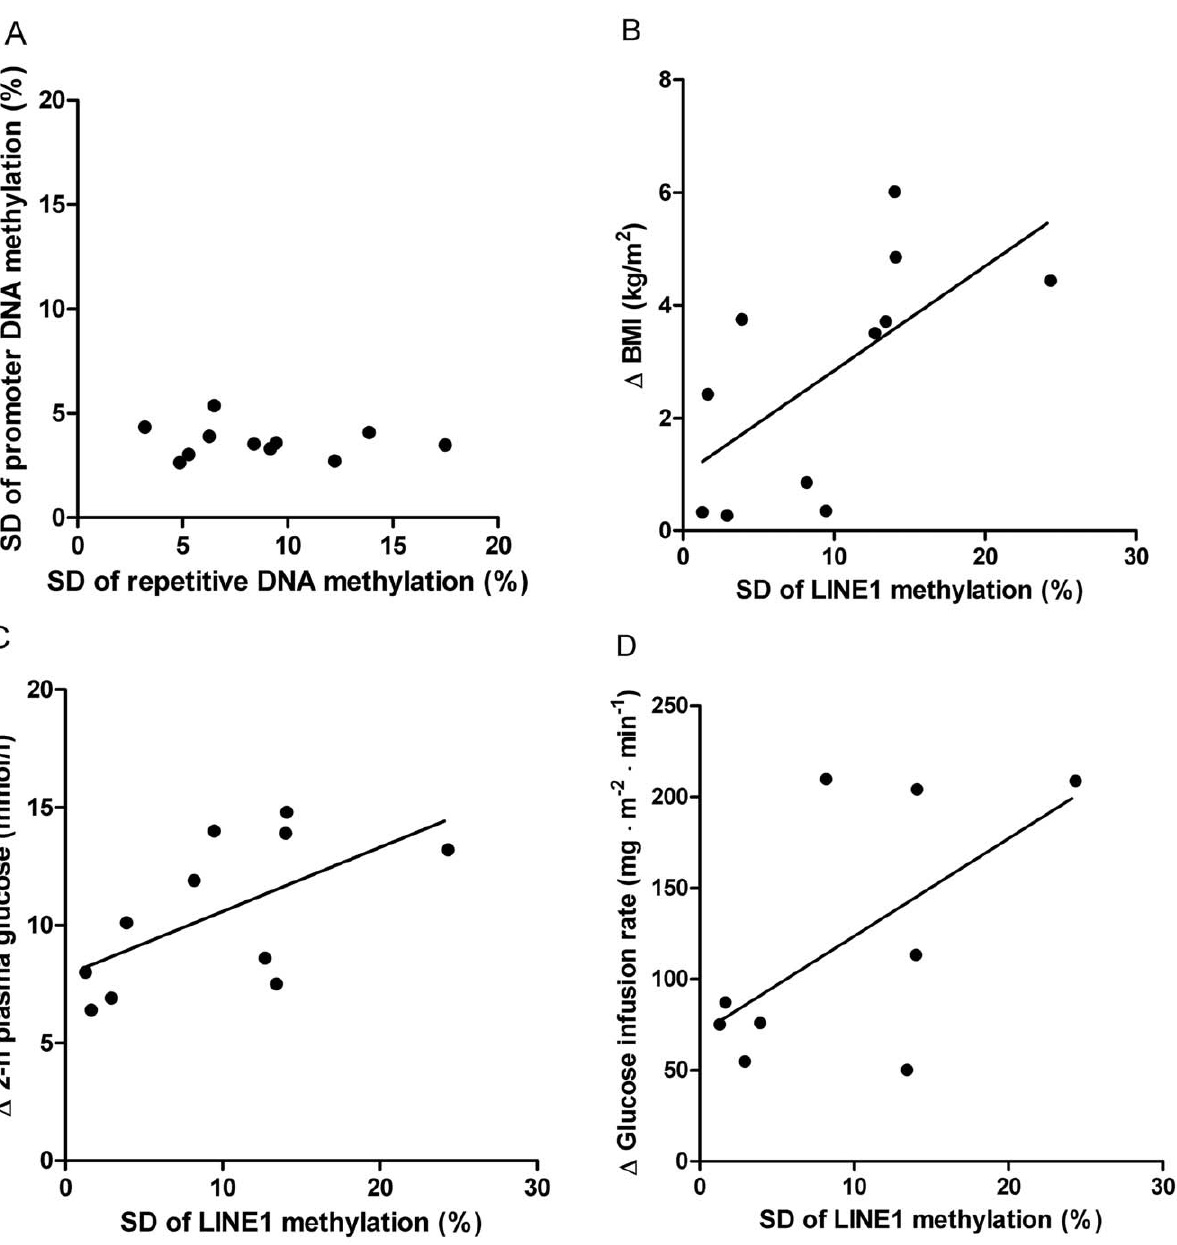
Figure 3. Intra-twin pair variation of DNA methylation in repetitive DNA sequences. The variation is given by the standard deviation (SD) of the absolute methylation differences between monozygotic twins in skeletal muscle. A SD of methylation differences on all repetitive versus all promoter CpG sites (r= 2 0.05, P =0.9). B SD of methylation differences on LINE1 repetitive CpG sites versus absolute difference in BMI (r=0.77, P =0.007). C SD of methylation differences on LINE1 repetitive CpG sites versus absolute difference in 2-hour plasma glucose (r=0.66, P =0.03). D SD of methylation differences on LINE1 repetitive CpG sites versus absolute difference in glucose infusion rate (r=0.52, P =0.2).